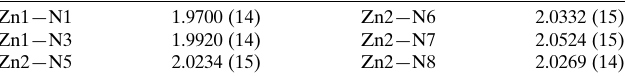
Table 1 Selected bond lengths (A˚ ).